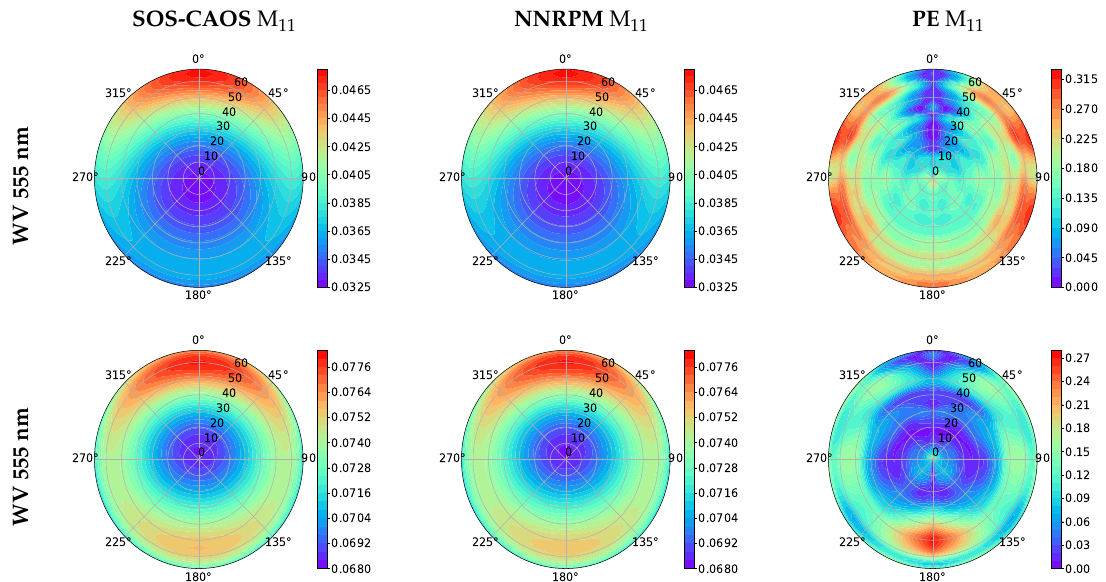
Figure 6. Polar plots of SOS-CAOS, NNRPM and PE for M 11 at wavelength 555 nm. Input parameters for Top Row: θ i = 55.91 ◦ , Chla = 20.43 mg/m 3 , a dg ( 440 ) = 0.258 m − 1 , b bp = 0.088 m − 1 , B p = 0.016, S Bp = − 0.157 nm − 1 , S bp = 0.258 nm − 1 , S dg = 0.019 nm − 1 . Input parameters for Bottom Row: θ i = 43.02 ◦ , Chla = 24.77 mg/m 3 , a dg ( 440 ) = 0.0004 m − 1 , b bp = 0.098 m − 1 , B p = 0.048, S Bp = − 0.106 nm − 1 , S bp = 0.023 nm − 1 , S dg = 0.014 nm − 1 .